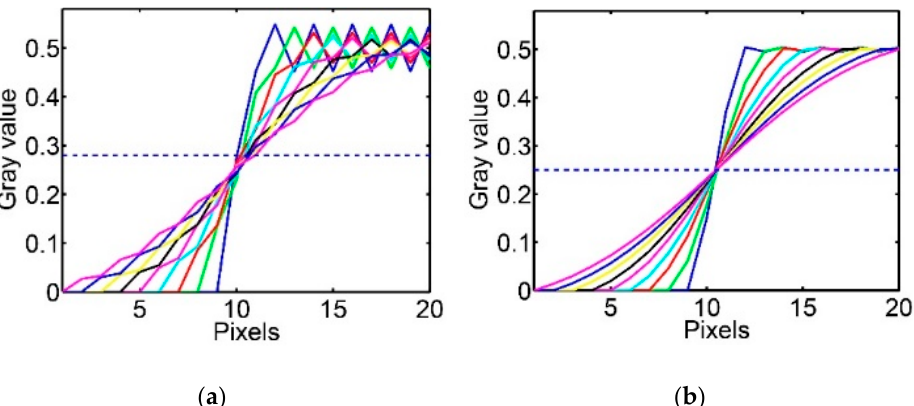
Figure 5. Simulation results for the intersection part under different defocusing levels. ( a ) Conventional ternary Gray-code method; ( b ) Improved ternary Gray-code